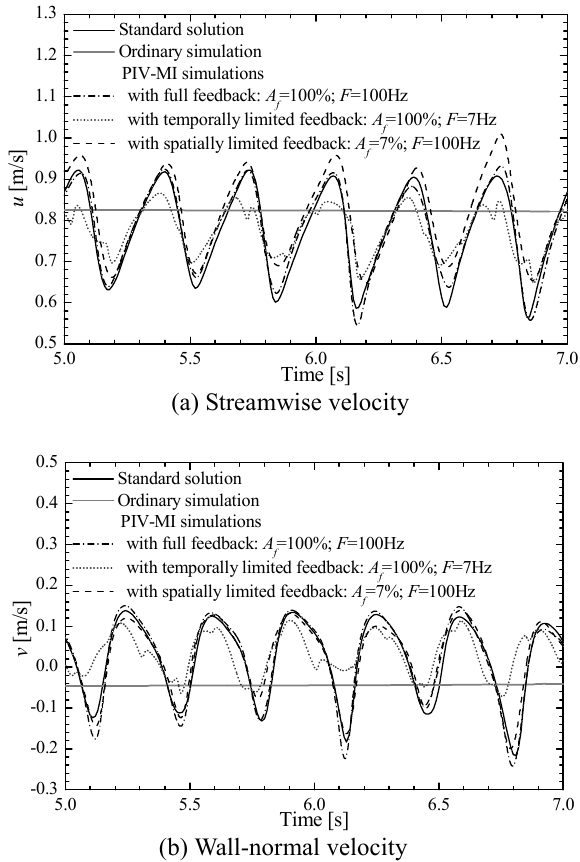
Fig. 3 Time histories of velocity at the monitoring